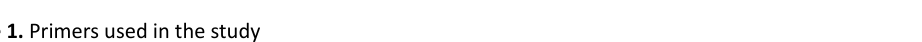
Table 1. Primers used in the study S.